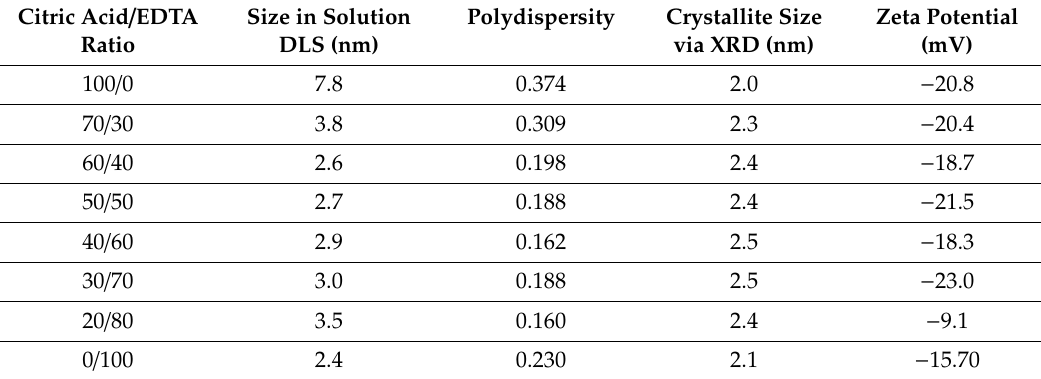
Table 1. Physiochemical characteristics of the CA / EDTA-stabilized cerium oxide nanoparticle (CeNP)